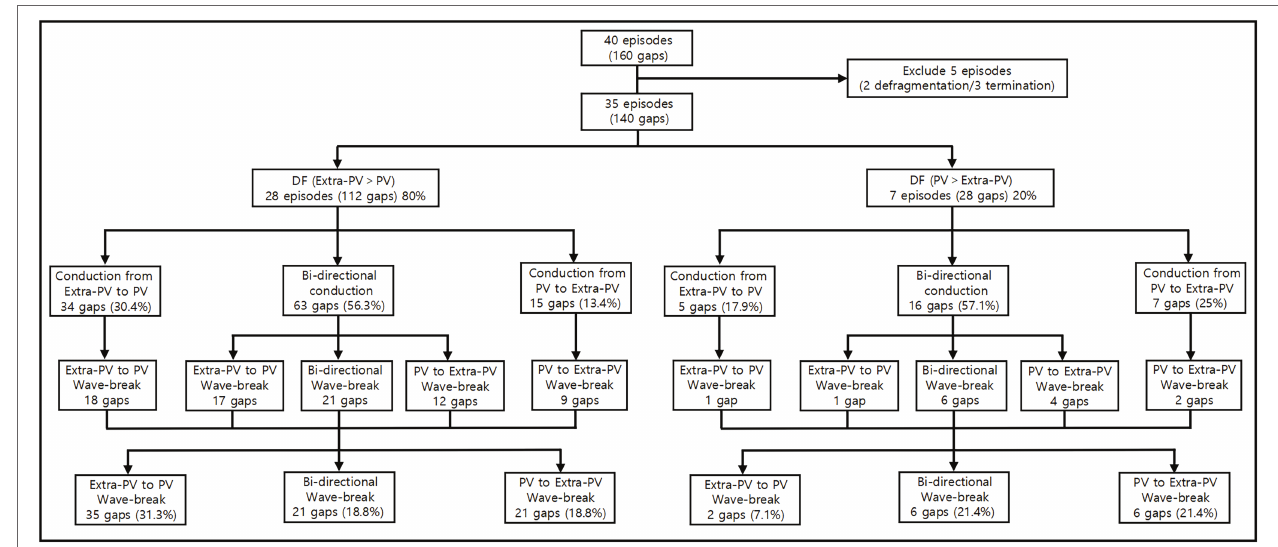
FIGURE 3 | Wave-dynamic interactions between the PVs and extra-PVs in 35 ongoing AF episodes after the PVI-gap intervention. DF indicates dominant frequency; PV, pulmonary